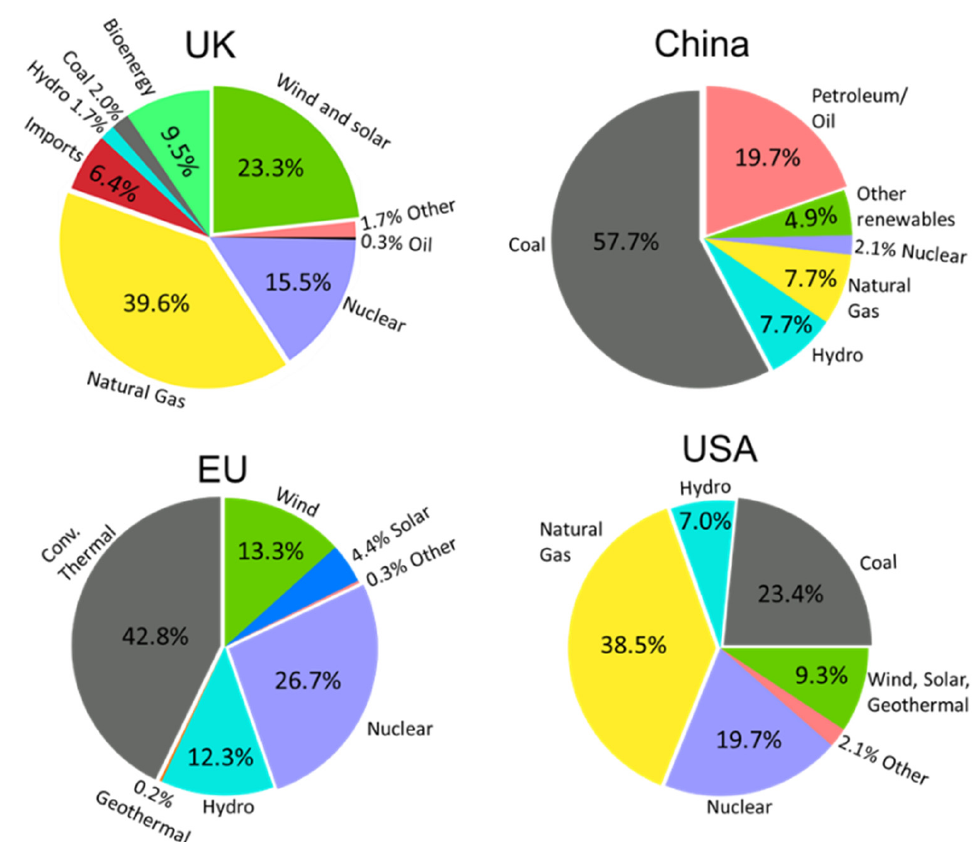
Figure 1. Power generation by fuel type (2019 data) for the UK [2], the EU [3], China [4], and the USA [5]. Conventional thermal includes traditional thermal plants, e.g., coal, oil and gas.